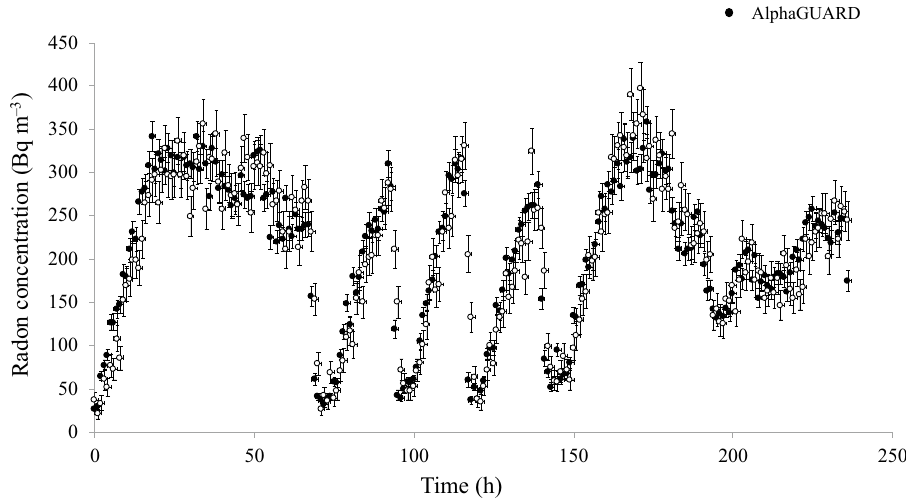
Figure 1. Intercomparison between AlphaGUARD PQ2000PRO (in diffusion mode) and TERA TSR 4 M active device exposed in a room for about 10 days. An acquisition time of 1 h was chosen for both the instruments. The uncertainties reported in the graph have a coverage factor k equal to